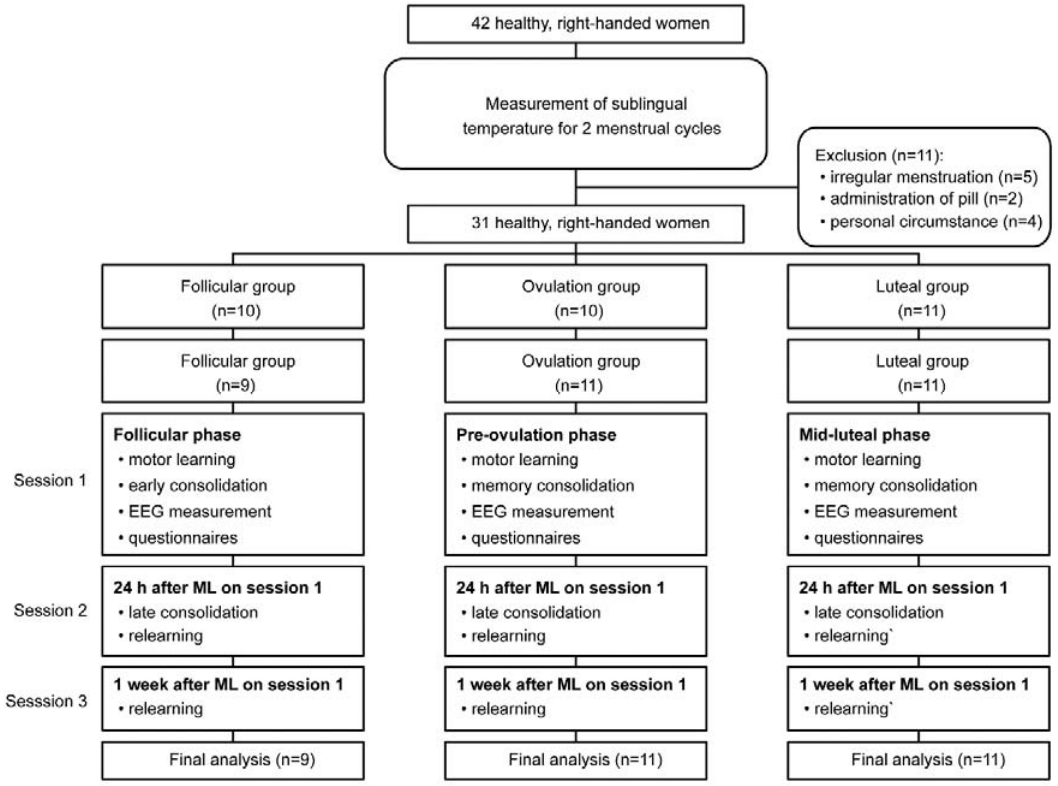
Figure 1. Participant assignment flowchart and overall schedule.